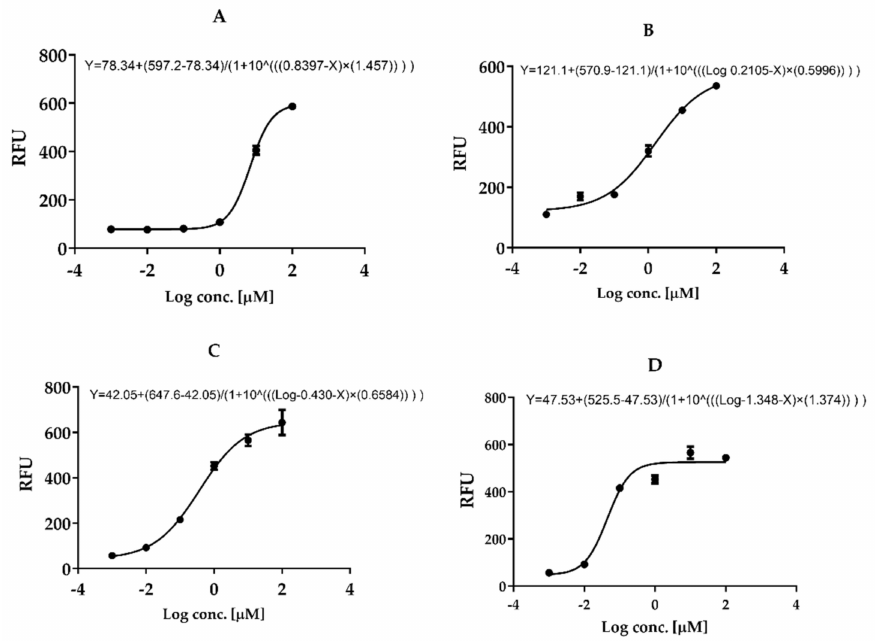
Figure 6. Inhibition of 3CL Protease enzyme activity by SIT ( A ), MEL ( B ), SIT-MEL ( C ) and GC376 inhibitor control ( D